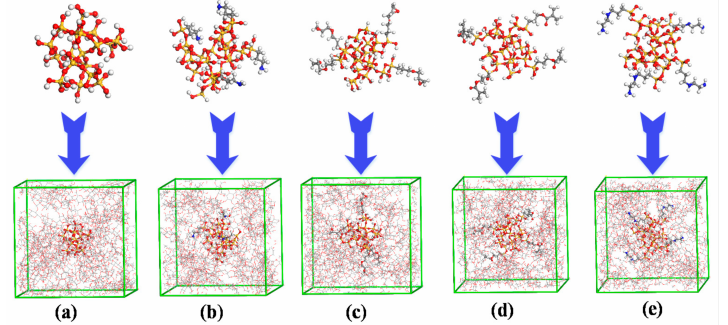
Figure 1. Composite models: ( a ) unmodified model, ( b ) KH550 model, ( c ) KH560 model, ( d ) KH570 model, and ( e ) KH792